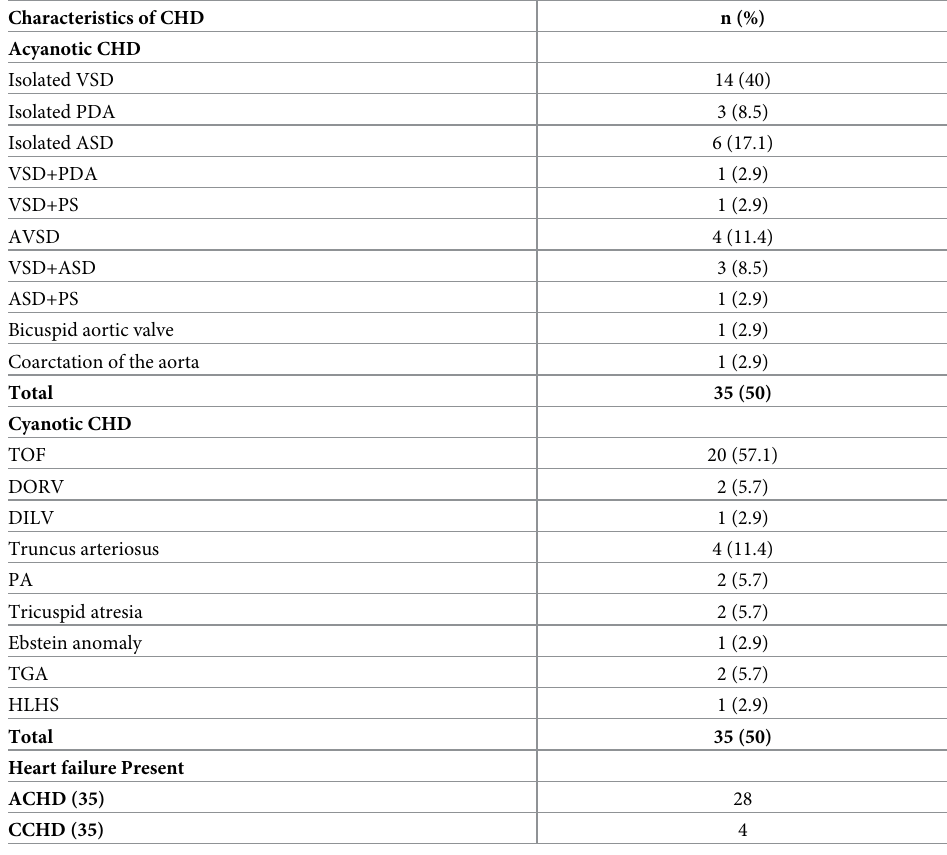
Table 2. Distribution of congenital heart defects. Characteristics of